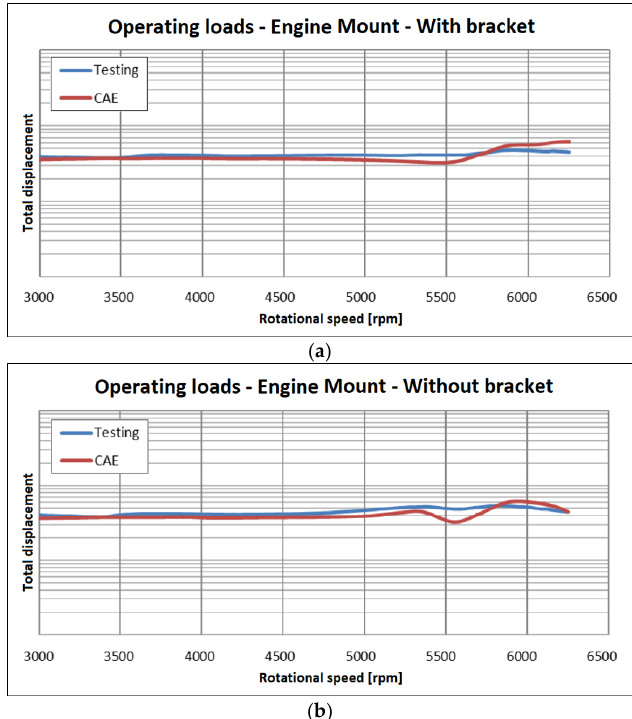
Figure 9. Experimental / numerical comparison in terms of displacements at the engine mount ( a ) with and ( b ) without consideration of the bracket (highlighted in Figure